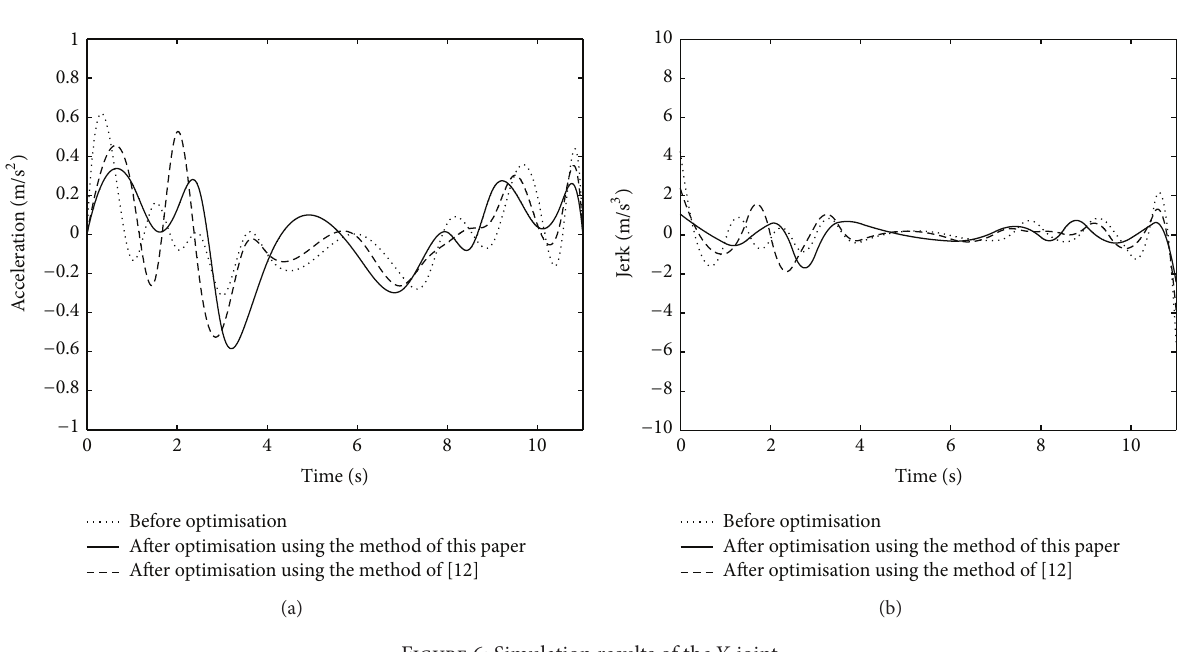
Figure 6: Simulation results of the 𝑌